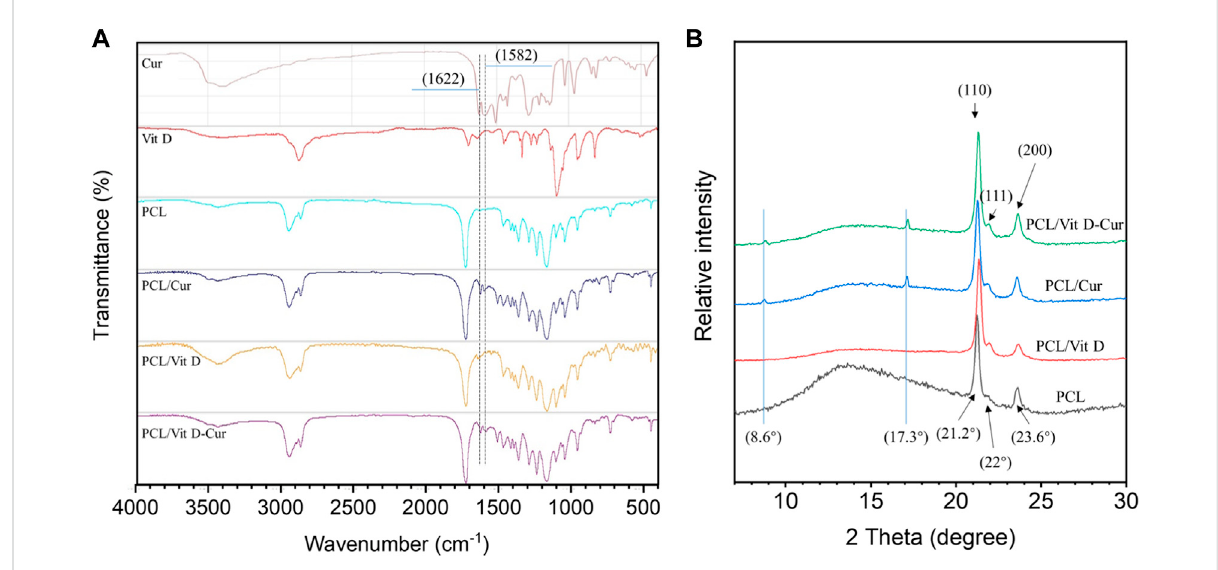
FIGURE 3 (A) FTIR spectra and (B) XRD patterns of different